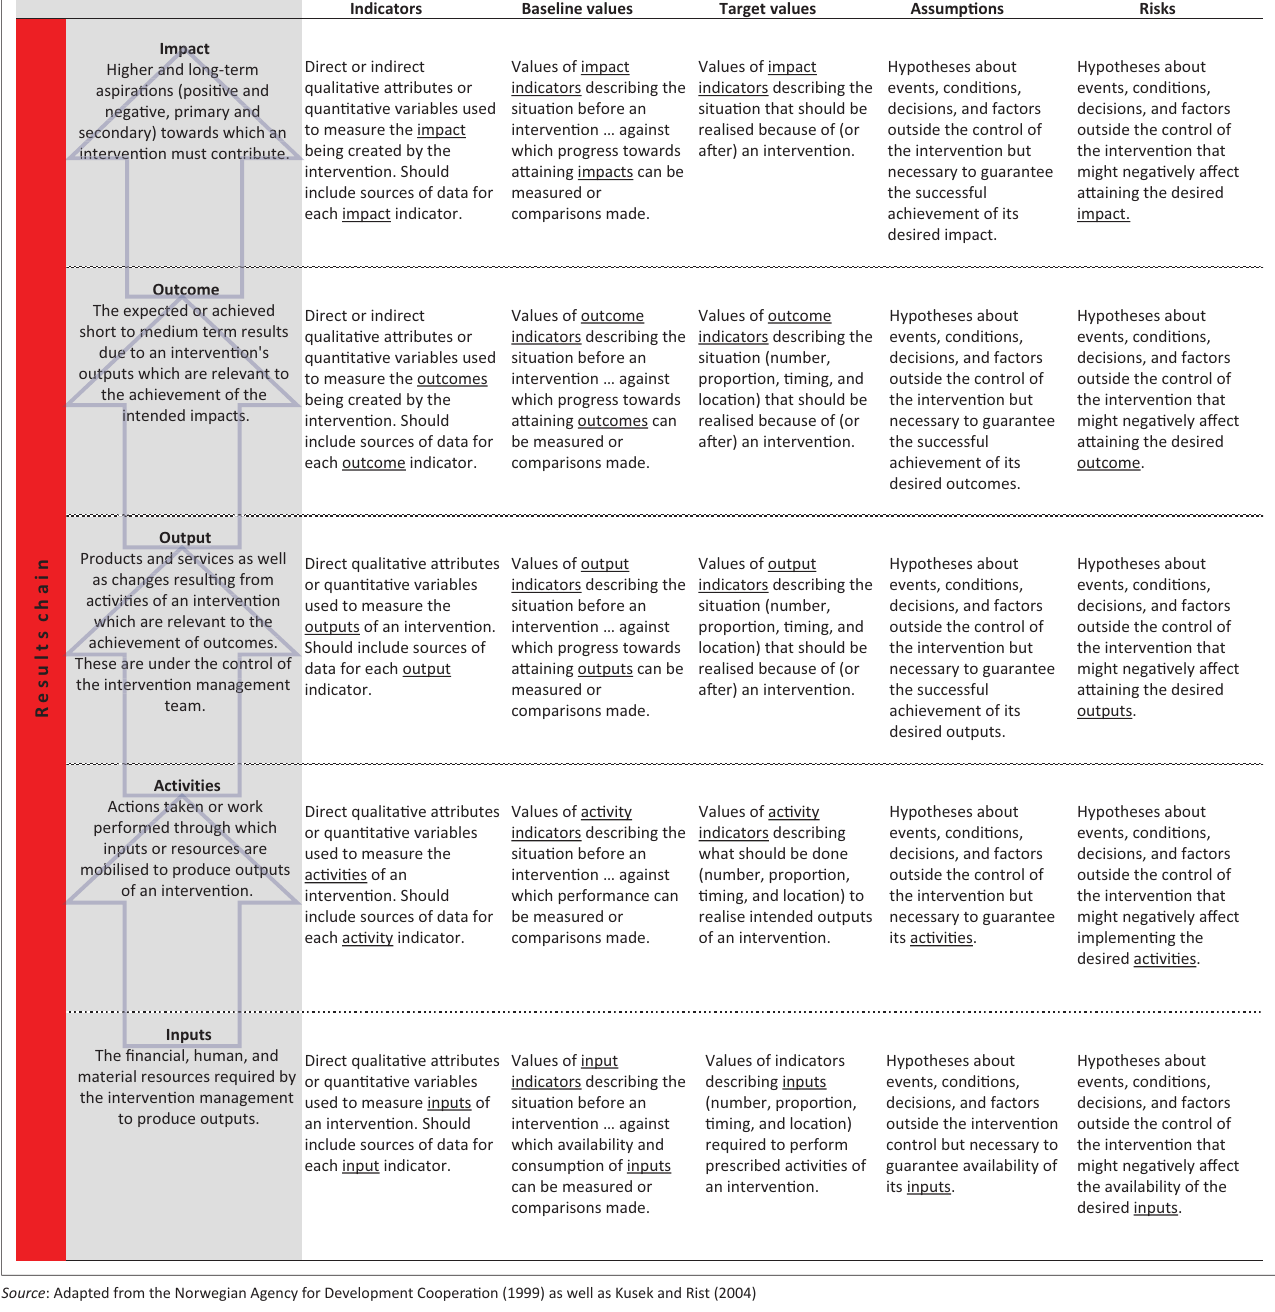
FIGURE 8: Illustrating the important elements of the results chain and the results framework.